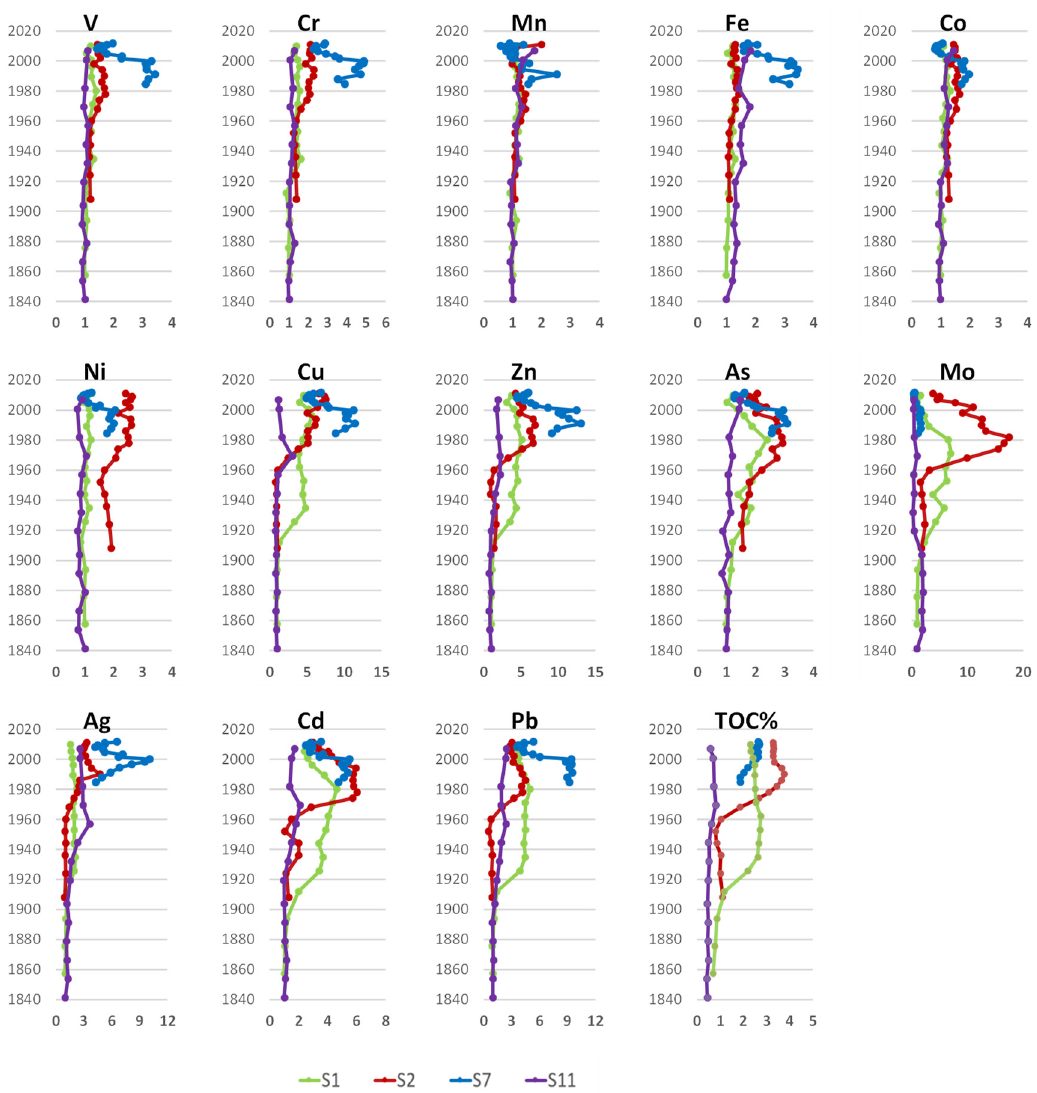
Figure 10. Time-dependent distribution of the enrichment factors of metals and TOC% at the S1, S2, S7, and S11 stations. Table 5. Metal toxicity risk assessment of the Elefsis Bay and Inner Saronikos Gulf sediments based on the RAC and SQGs.